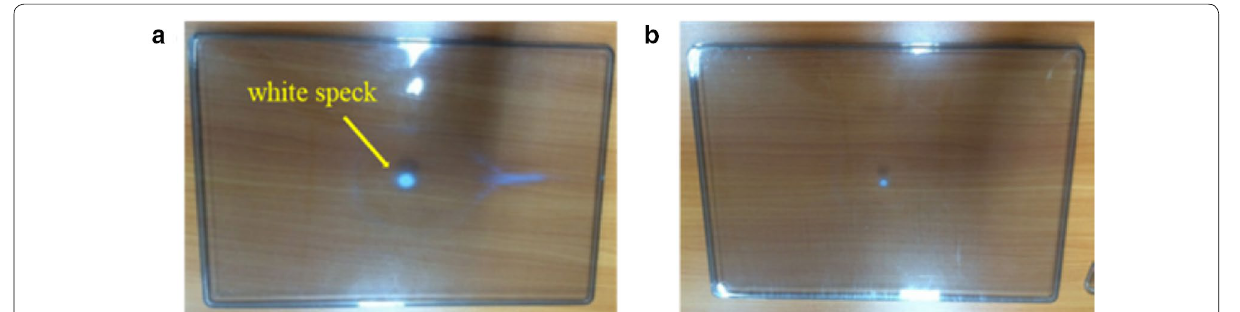
Figure 11 Transparent box covers produced by two kinds of mold: a traditional mold; b SLM